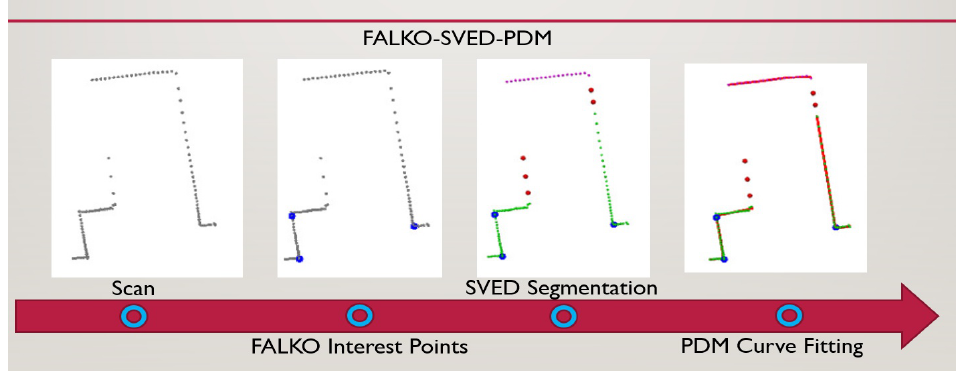
Figure 2. The three steps of proposed approach applied on a scan: FALKO interest point detection, segmentation, and finally, B-spline curve fitting. Note: Control points of B-splines are not shown in the